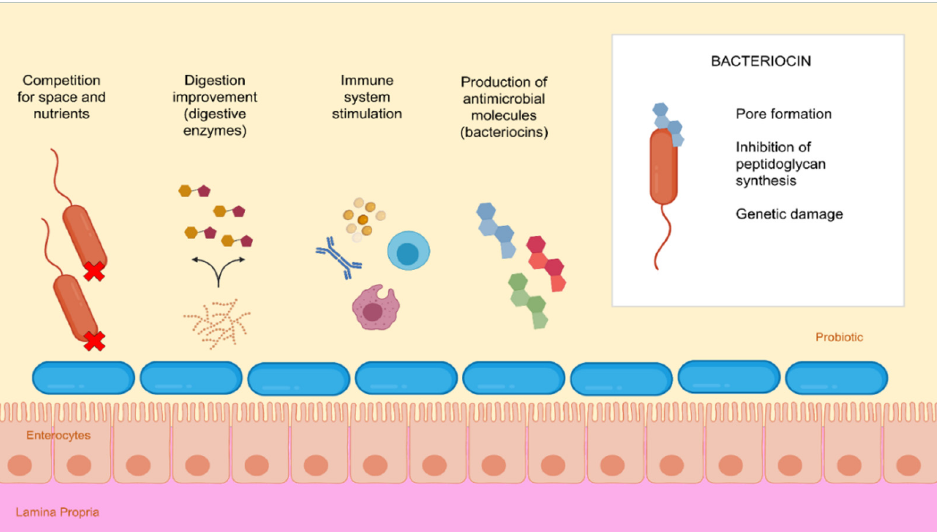
Figure 2. Probiotics and bacteriocins mode of action. Probiotics beneficial effects come from several mechanisms. They secrete digestive enzymes that contribute to macronutrients breakdown, increasing absorption by the host. They can act by blocking pathogens due to competition for space and nutrients, by stimulating the immune system (without the presence of disease) and via the production of antimicrobial substances (such as lactic acid and bacteriocins). Bacteriocins mode of action may vary according to their characteristics. They can lead to death via pore formation, preventing the action of peptidoglycan transporters and, consequently, cell wall synthesis, and via damage to genetic material and protein synthesis. Probiotics, bacteriocins, and the host nutritional improvement contribute to pathogens elimination and diseases control